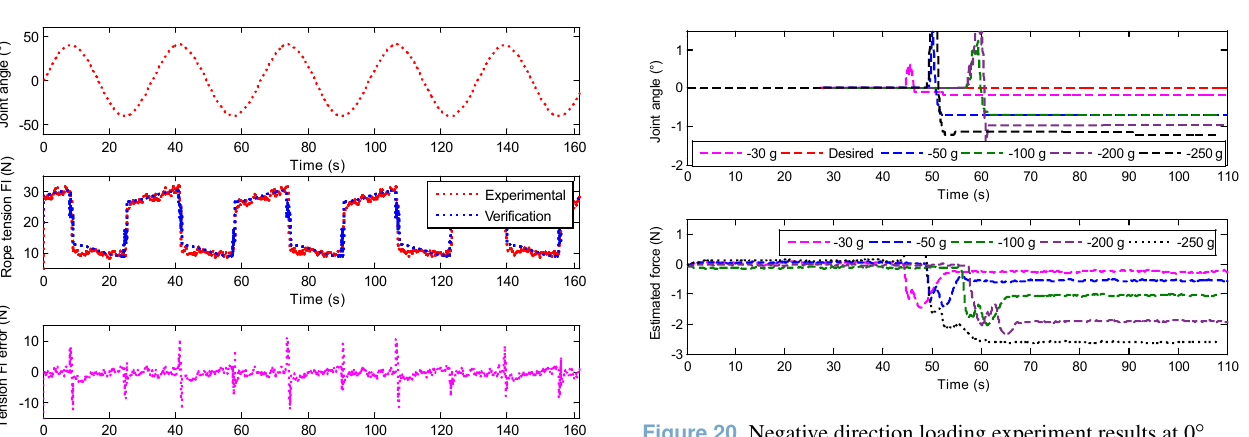
Figure 20. Negative direction loading experiment results at 0 ◦ .